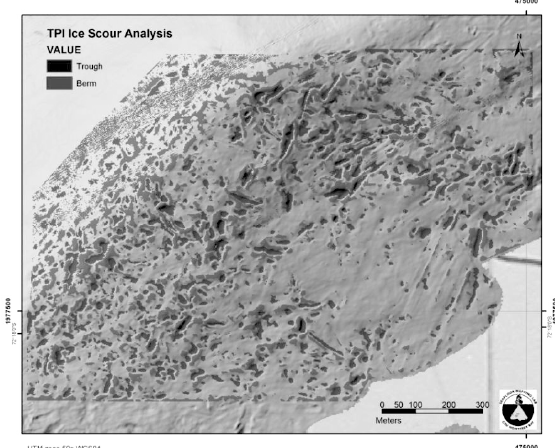
F IG . 3. – Representative shaded relief multibeam image of the marine bottom in the Cape Hallett area along the Victoria Land Coast of Antarctica in the vicinity of 72°18’S and 170°16’E at 40- 50 m depth. Topographic Position Index (TPI) analysis was applied to a 2 m Digital Elevation Model (DEM) grid of the same area and “tuned” to detect troughs (black) and berms (dark gray). These results indicate that 28.95% (12.72% troughs and 16.23% berms) of the 1,376,328 m 2 area was scoured by icebergs. The multibeam sur- veys on the R/V “Italica” cruise were produced by the Seafloor Mapping Lab from California State University Monterey